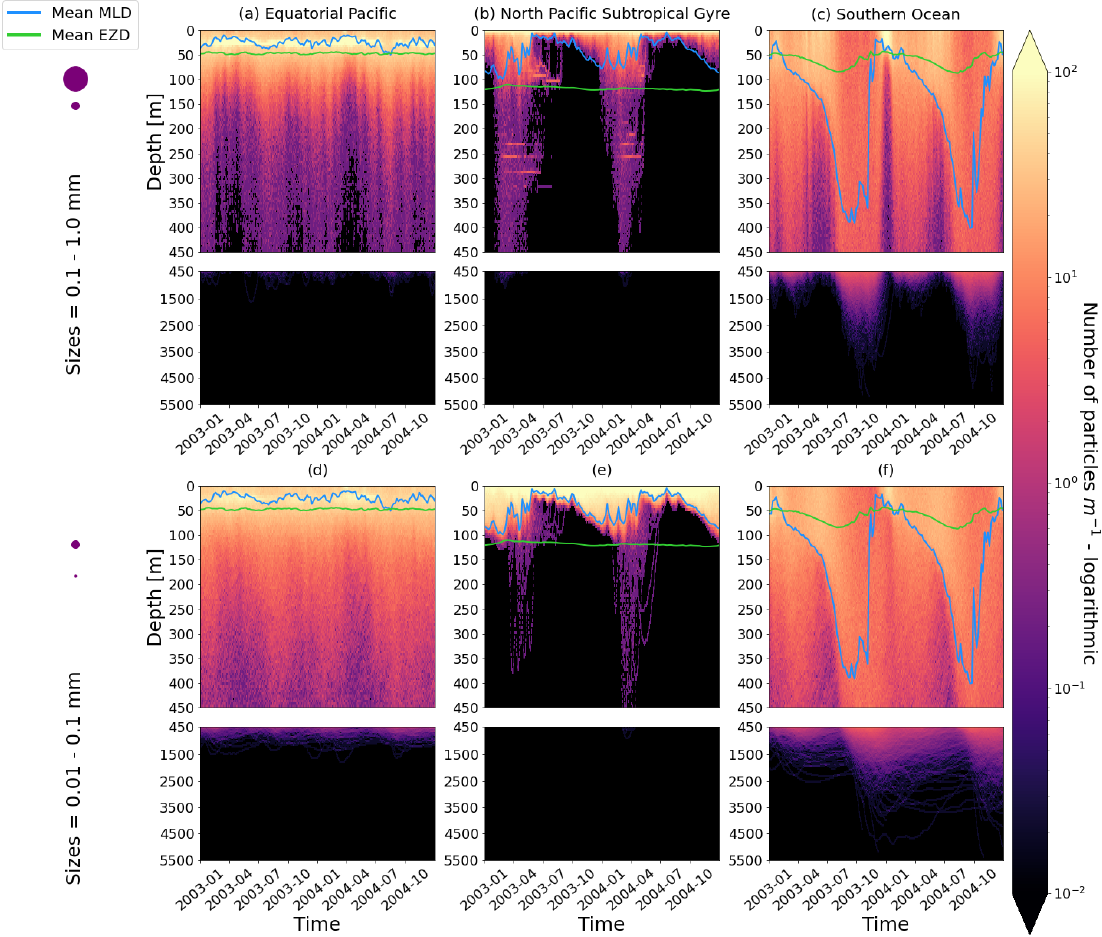
Figure B1. As in Fig. 2 but for 2 years (from 1 January 2002 to 31 December